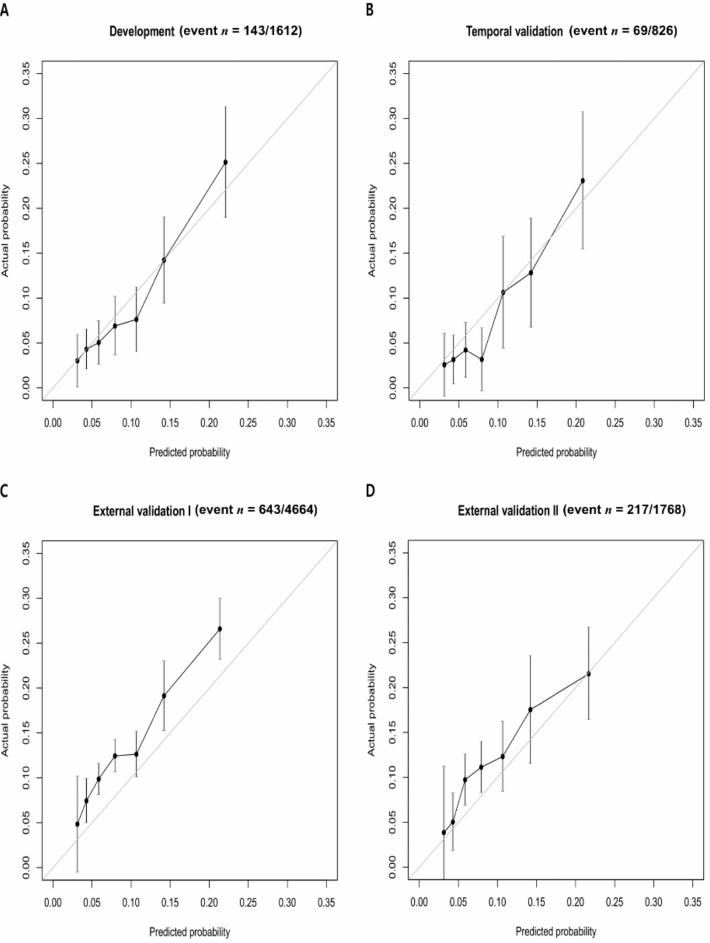
Figure 3. Calibration plot of OFRS in ( A ) development cohort, ( B ) temporal validation cohort,